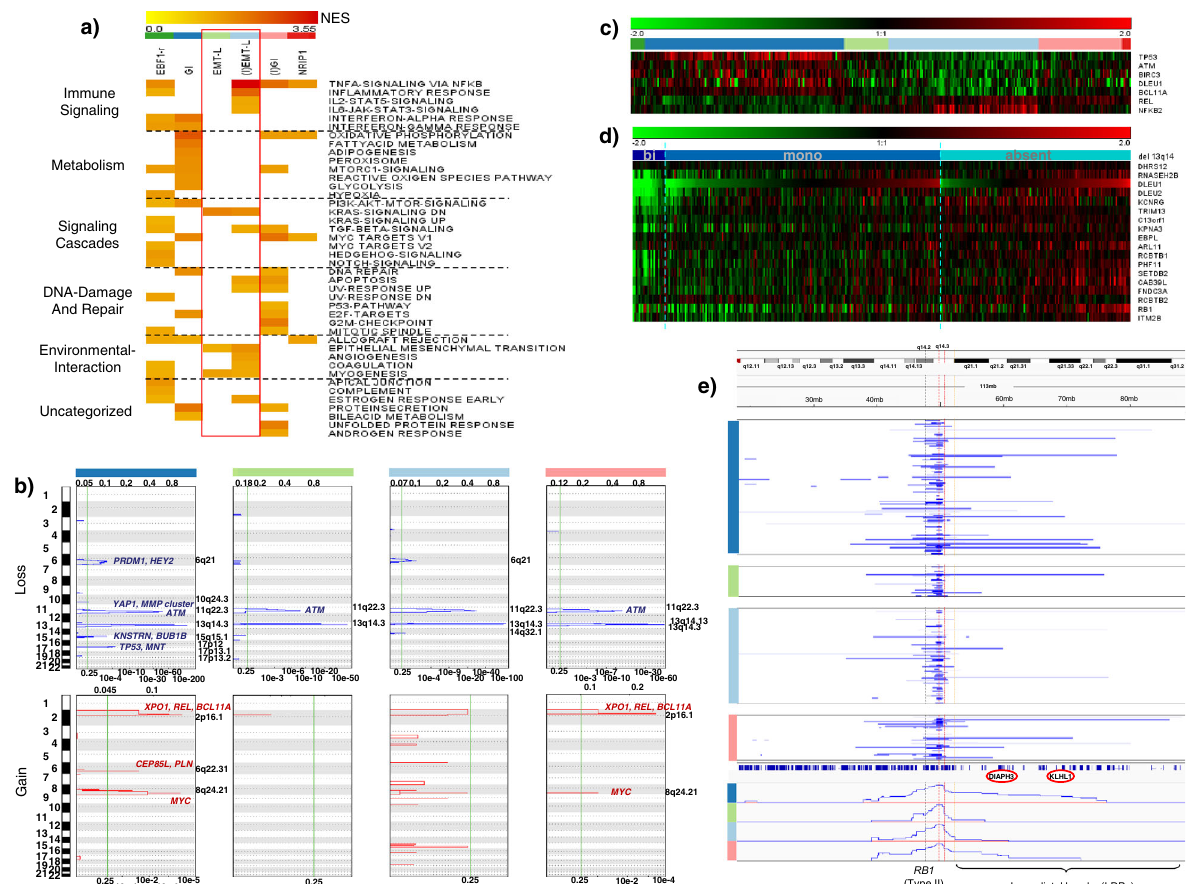
Fig. 2 Pathway activation and genetic alterations in CLL subtypes. a Heatmap showing overrepresented gene sets (FDR < 0.05) identi fi ed through GSEA. The intensity range of normalized enrichment scores (NES) illustrates the degree of enrichment in CLL subtypes. Gene sets are grouped together according to the biological context. CLL subtype color code de fi ned in Fig. 2a applies for Fig. 2a – c, e. b GISTIC analysis of copy number alterations (CNA). Chromosomal positions (1 – 22) on the y -axis (left) indicate losses (blue, upper panels) or gains (red, lower panels) for major clusters. Affected genes representing CNA targets within biological networks (such as YAP1 ) are shown for respective peaks. The most signi fi cant chromosomal peaks for major clusters are indicated on the right of each panel. GISTIC q -values at each locus are plotted from left to right on a log scale (bottom of each panel). Altered regions with FDR q ≤ 0.25 (vertical green line) are considered signi fi cant. GISTIC G-Scores (amplitude of the aberration × frequency of its occurrence across samples) are plotted on top of the panels. c Heatmap showing GEP of genes located within or adjacent to the minimally deleted or minimally gained regions of recurrent aberrations ( n = 337). FDRs for DEGs ((I)EMT-L vs. GI) are highly signi fi cant ( q < 1e − 07). d Heatmap showing GEP of genes located at/adjacent to the minimally deleted region on 13q ( n = 335). The blue color code indicates deletions (dark blue: biallelic; light blue: monoallelic) and the absence of del(13q) (cyan blue). Genes are ordered corresponding to chromosomal positions for the region between DLEU1 and RB1 . e Visualization of del(13q) per case (blue horizontal lines). y -Axis: cluster color code, x -axis: representative genes and topography for the cumulative coverage of segment breaks per cluster. A vertical black dotted line indicates the RB1 locus. Vertical red dotted lines indicate the majority of distal losses (around 50 – 51 mb). Losses extending to the distal end of cytoband 13q14.3 (orange dotted line) are variably distributed. LDBs involve/exceed the majority of cytoband 13q21.1 (distal of 54.7 mb). Biallelic deletions of 13q14 mostly cover a small region and rarely occur together with larger 13q deletions. For Fig. 2a – e, data within individual fi gures derives from biologically independent